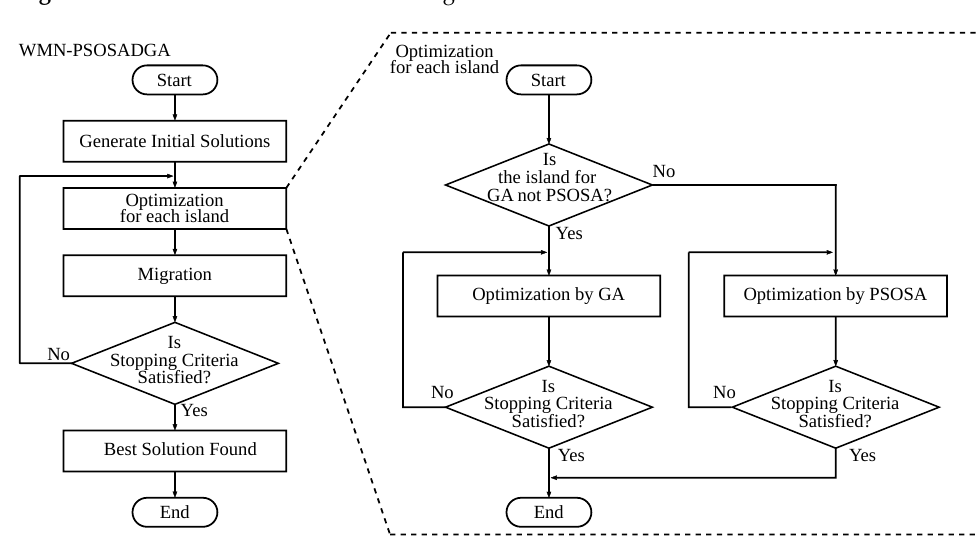
Figure 5. Flowchart of